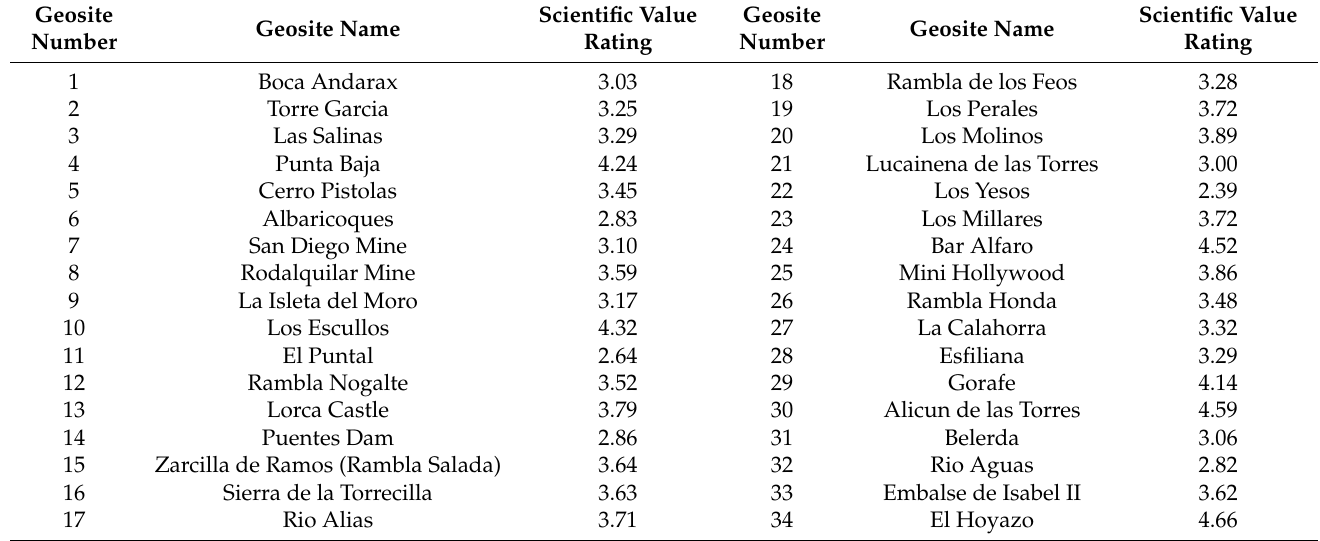
Table A5. Mean scientific value ratings of the 34 geosites, rated by the GB-V group ( n = 29